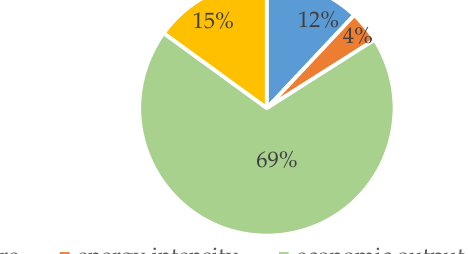
Table source: Data interval covered 1995 to 2014. Energy structure X 2 i = E i / E denotes the proportion of i th fossil energy in total energy consumption; Energy intensity X 3 i = E / Y refers to the energy consumption of per unit GDP; X 4 i = Y / P represents per capital of GDP; and X 5 i = P refers to population scale. The total population and GDP of the Beijing, Tianjin, Hebei provinces were derived from the Beijing Statistical Yearbook, Tianjin Statistical Yearbook, and Hebei Economic Yearbook. Moreover, the GDP was converted to 1995 price to eliminate inflation.